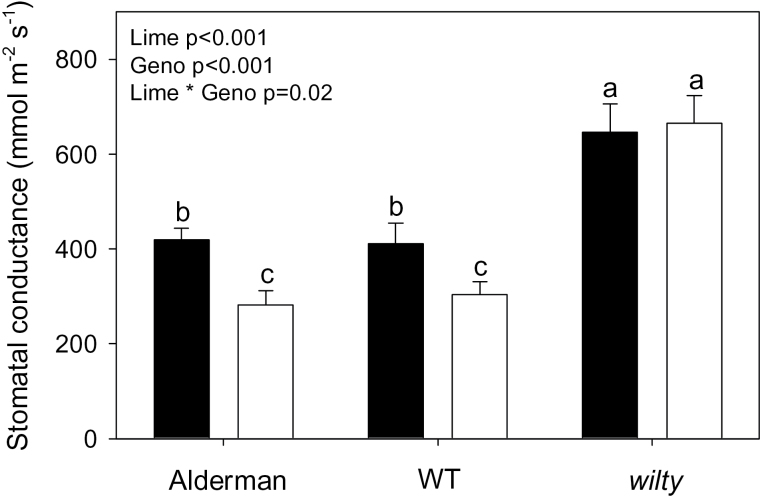
Stomatal conductance of limed (open bars) or unlimed (filled bars) Pisum sativum cv. Alderman (Ald), ‘wild-type’ (WT) or wilty. Data are means ±SE of 7–8 replicates, and two-way ANOVA results (P-values reported) are shown. Different letters above each bar indicate significant differences (P<0.05) as determined by Tukey pair-wise analysis.